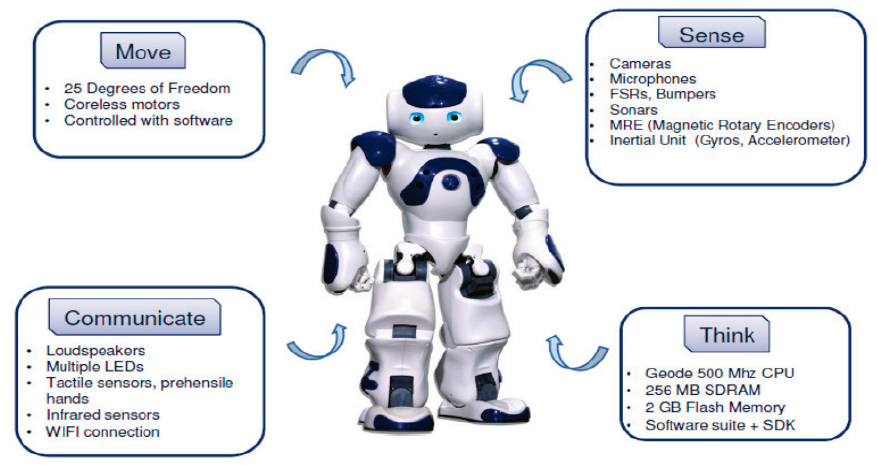
Figure 6. NAO robot capabilities and sensors.